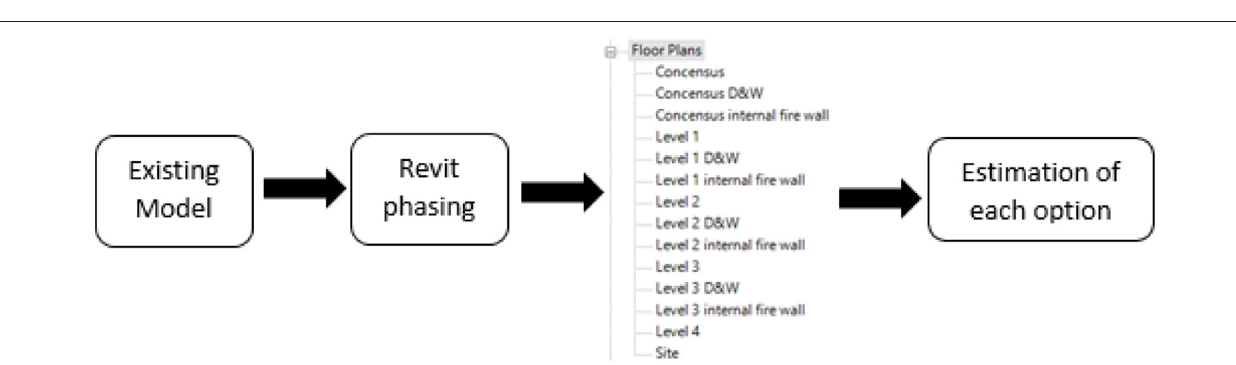
FIGURE 3 | Project renovation using Revit